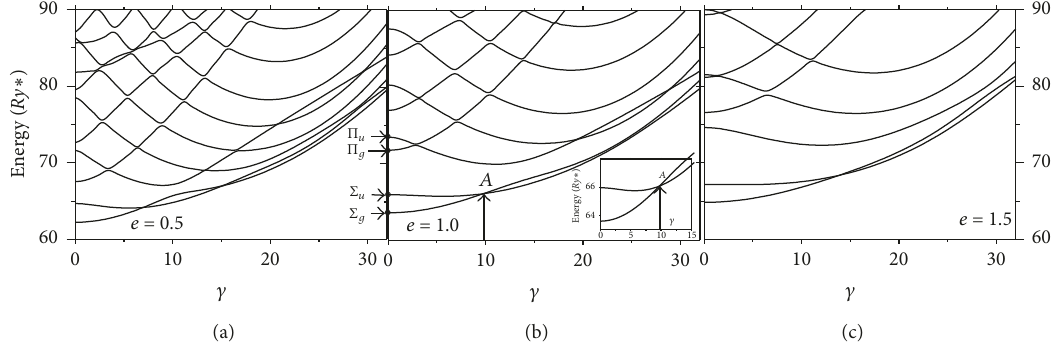
Figure 7: Energies of the on-center donor in elongated QR with parameters 𝑎 = 20nm, 𝑑 𝑟 = 4nm, 𝑑 ℎ = 2 nm, and 𝑒 = 0.5, 1.0 , and 1.5 , as functions of the external magnetic field. Inset in Figure 8(b) shows details of the first crossover of the lowest